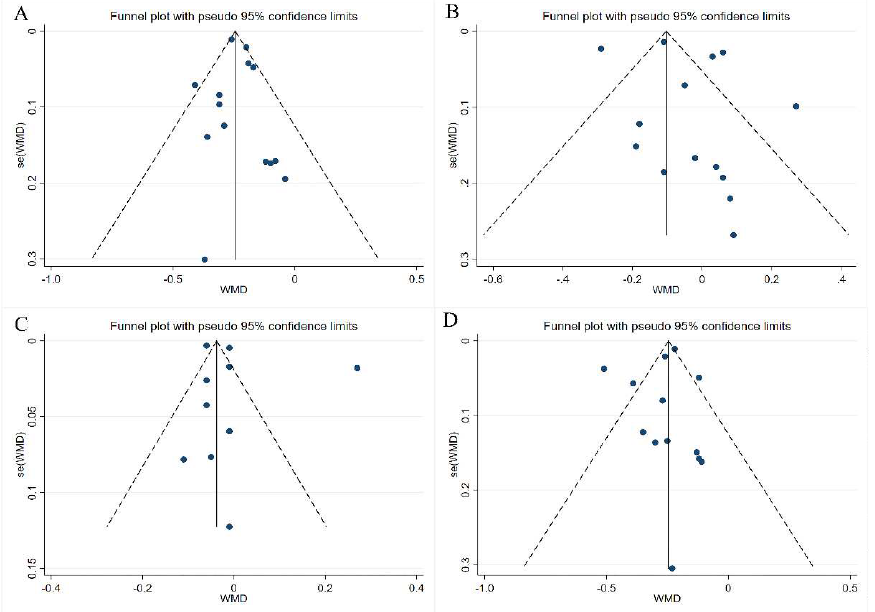
Figure 6. Funnel plots for exhibition of publication bias and oat β-glucan consumption for ( A ) TC Egger′s test ( p = 0.637), ( B ) TG Egger′s test ( p = 0.374), ( C ) HDL-C Egger’s test ( p = 0.366), ( D ) LDL-C Egger′s test ( p = 0.519). Solid line: combined effect size; Dashed line: 95% confidence interval.